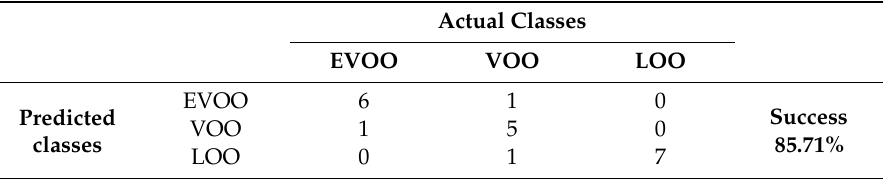
Table 3. Validation matrix by k-NN using HS-GC-IMS data.